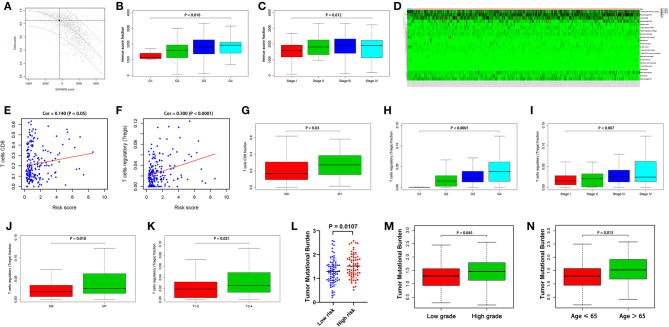
The relationship between the present signature and the tumor immune microenvironment (A) The tumor purity assessed with the ESTIMATE algorithm (B) The immune score and deteriorated histological grade (C) The immune score and advanced pathological stage (D) TIICs assessed with the CIBERSORT algorithm (E) The correlation between the risk score and CD8+ T cells (F) The correlation between the risk score and Tregs (G) CD8+ T cells fraction and the metastasis of RCC (H) Tregs fraction and deteriorated histological grade (I) Tregs fraction and advanced pathological stage (J) Tregs fraction and the metastasis of RCC (K) Tregs fraction and the tumor size (L) Increase in the TMB in the high-risk group (M) The TMB and deteriorated histological grade (N) Increase in the TMB with age. p < 0.05 was considered statistically significant.